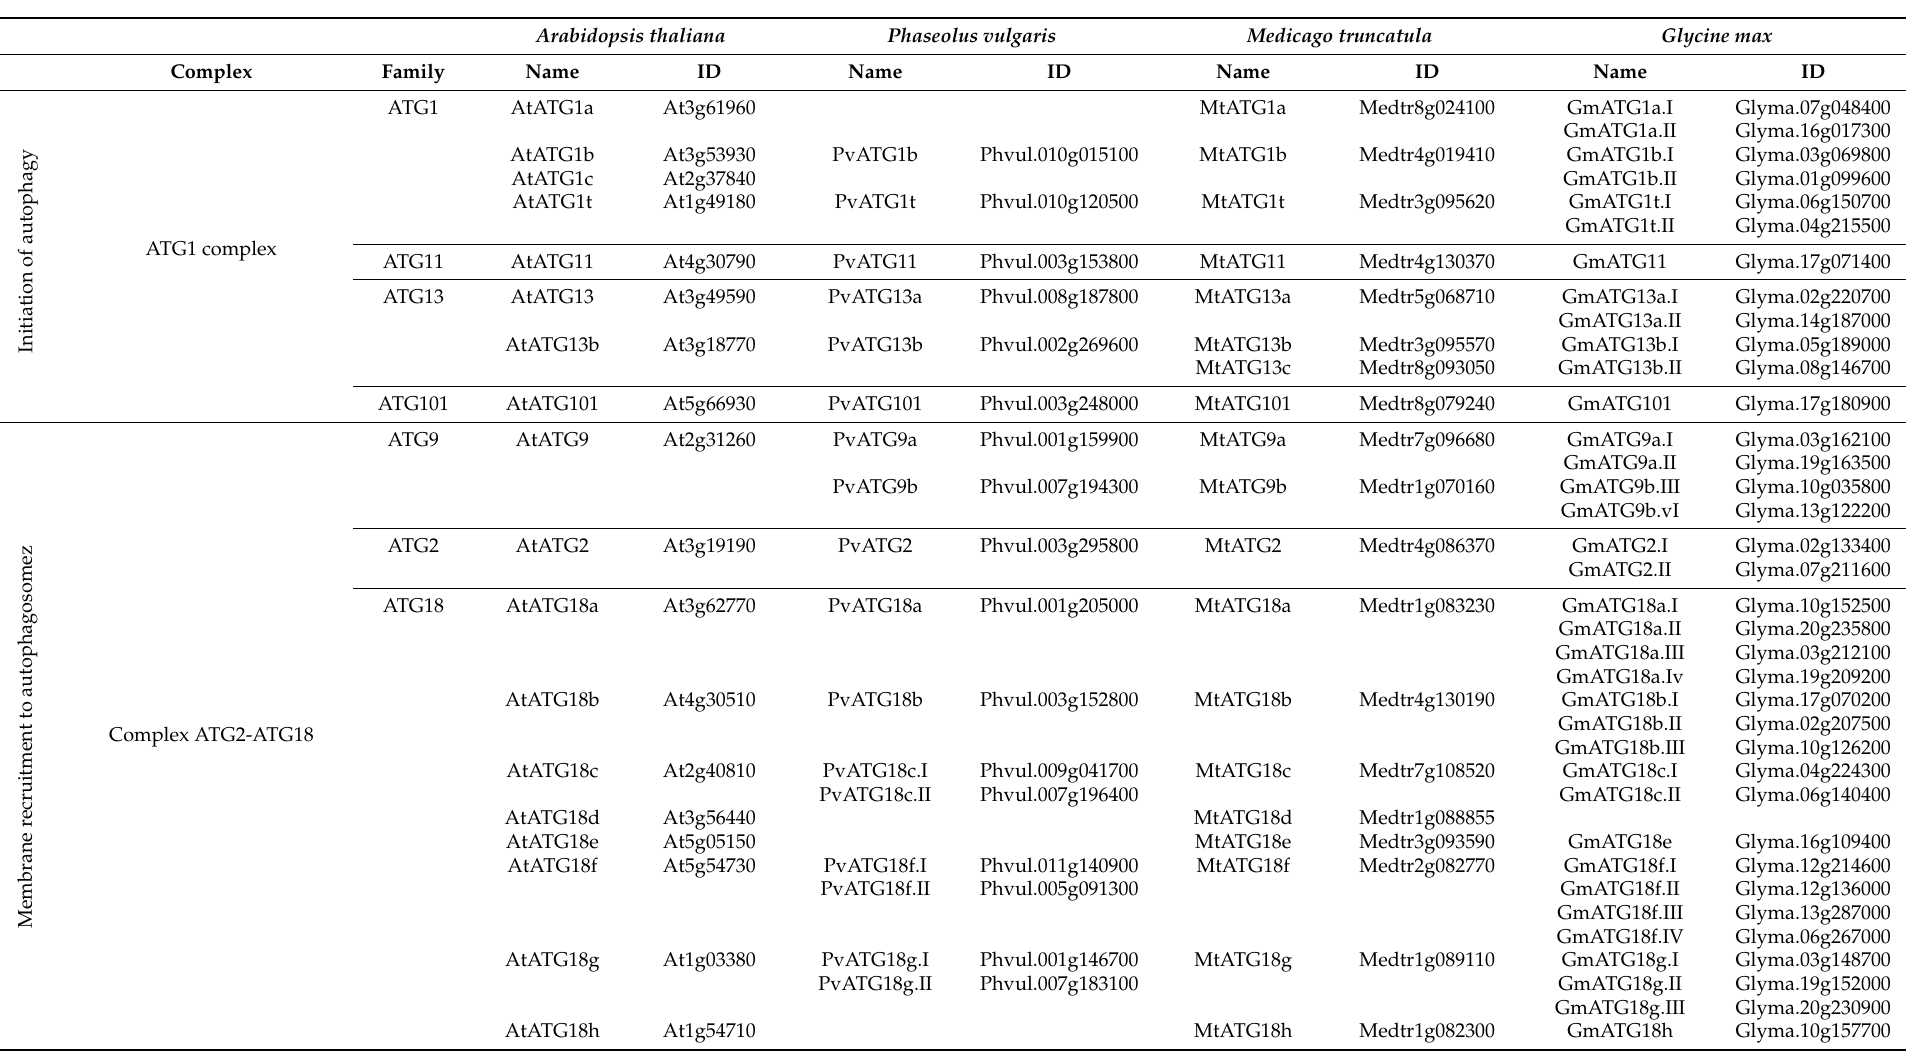
Table 1. List of 17 autophagy gene families in A. thaliana, P. vulgaris, M. truncatula and G. max